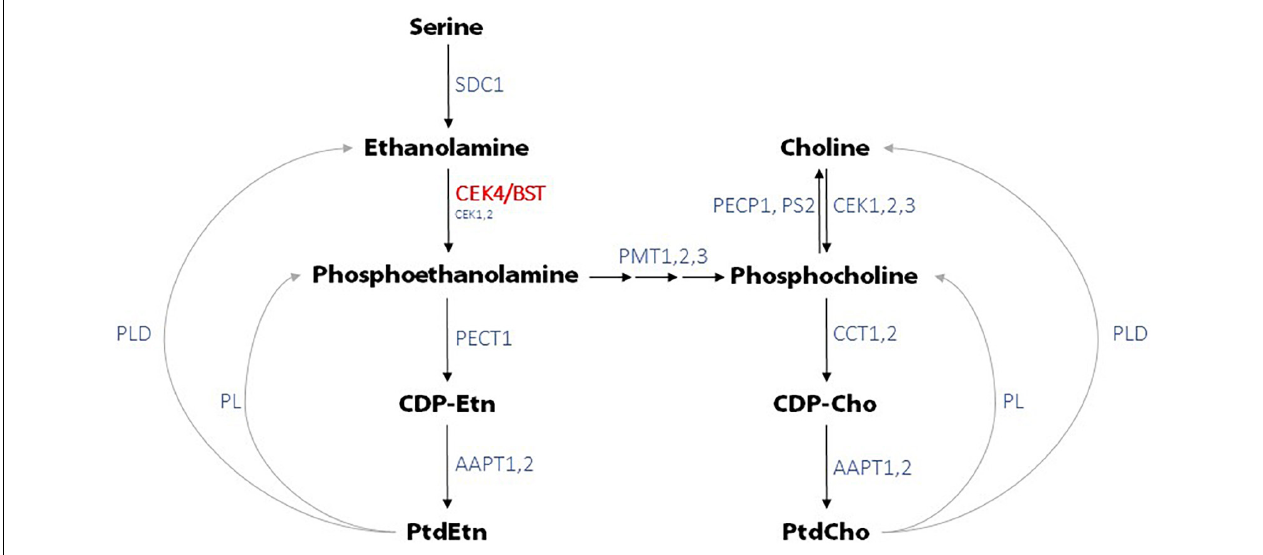
FIGURE 6 | Phosphatidylethanolamine (PtdEtn) and phosphatidylcholine (PtdCho) biosynthetic pathways in Arabidopsis. CEK4/BST functions as the principal ethanolamine kinase, directly producing phosphoethanolamine which is used to generate PtdEth. Through the activity of PMTs, CEK4/BST is also responsible for the production of PtdCho and other choline containing compounds. Enzymes not defined in the text are SDC1, serine decarboxylase 1; PECT1, CTP:phosphorylethanolamine cytidylyltransferase 1; AAPT1,2, aminoalcohol aminophosphotransferase 1,2; PL, phospholipase; PLD, phospholipase D; PECP1, phosphoethanolamine/phosphocholine phosphatase 1; PS2, phosphate starvation-induced gene 2; CCT1,2, CTP:phosphorylcholine cytidylyltransferase 1,2. CDP-Cho is cytidine diphosphocholine and CDP-Etn is cytidine diphosphoethanolamine. Adapted from models presented in Lin et al. (2015), Chen et al. (2019), and Liu et al.